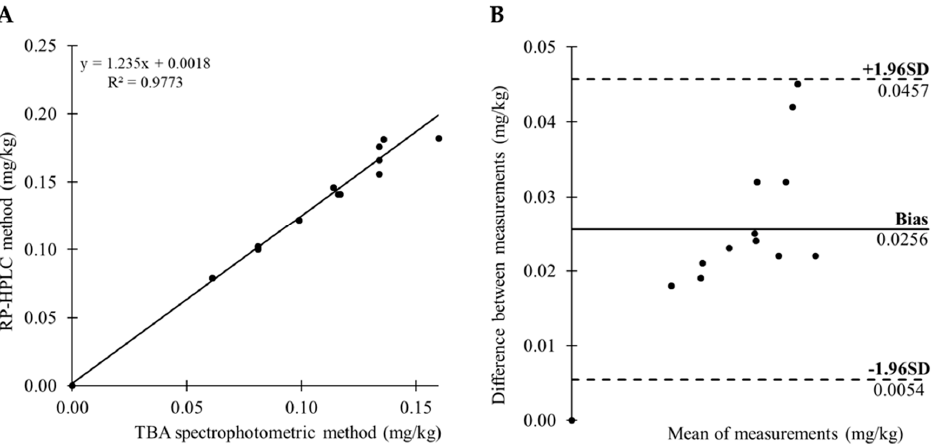
Figure 2. ( A ) Correlation graph between the malondialdehyde determinations by the TBA spectrophotometric and RP-HPLC method; ( B ) The Bland-Altman plot of TBA spectrophotometric and RP-HPLC